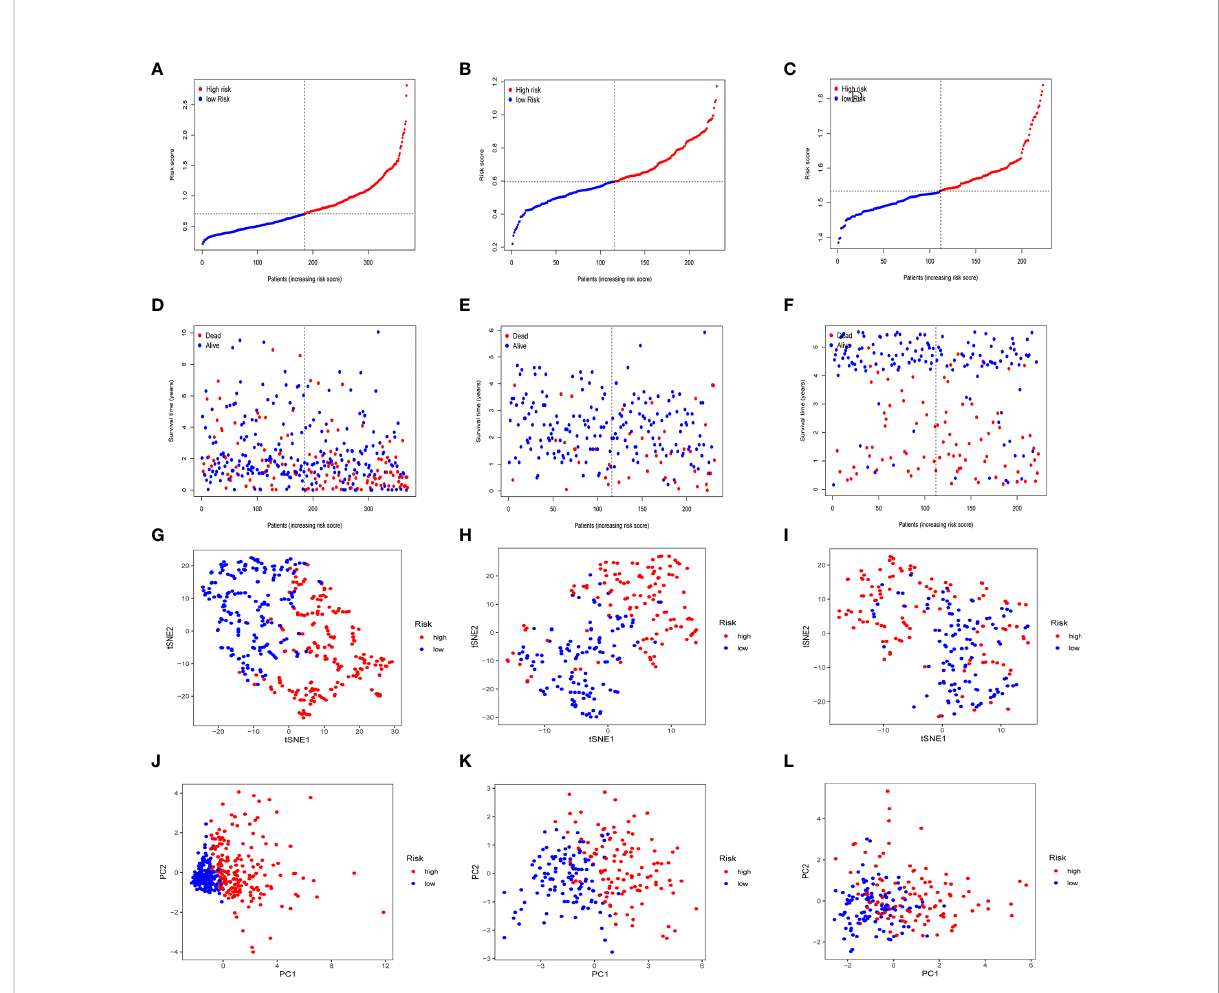
FIGURE 4 Prognostic analysis of prognostic models in the TCGA cohort, the ICGC cohort and GEO cohort. Patients ’ survival status and risk score in the TCGA cohort (A, D) , ICGC cohort (B, E) and GEO cohort (C, F) . PCA analysis and t-SNE analysis of high and low risk groups in the TCGA cohort (G, J) , ICGC cohort (H, K) and GEO cohort (I, L)